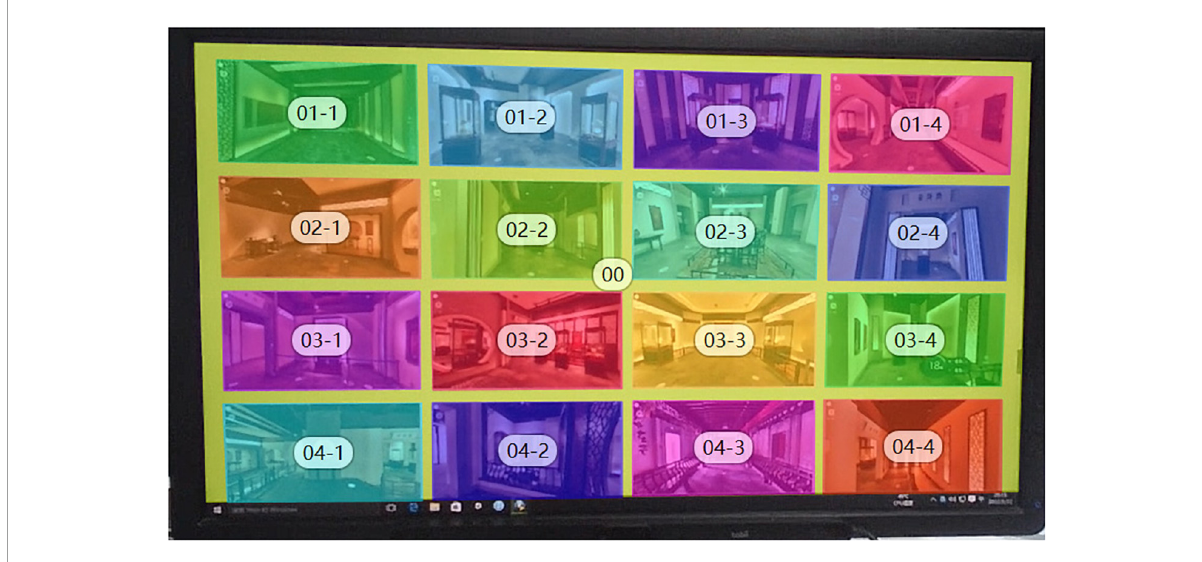
FIGURE6 Schematic diagram of AOI area division of digital museum space test map.